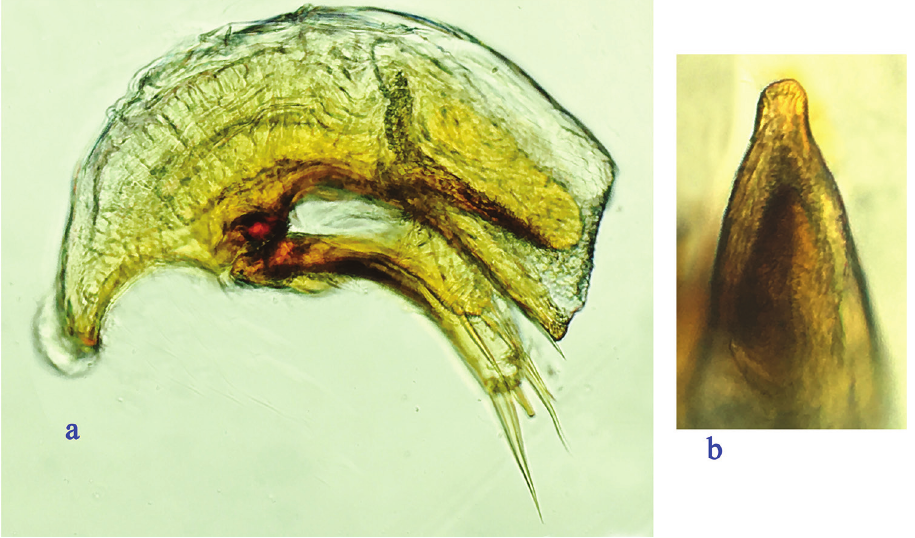
Figure 5. Male genitalia of Wanoblemus wui Tian & Fang, gen. n., sp. n. a median lobe and parameres, lateral view b apical lobe, dorsal